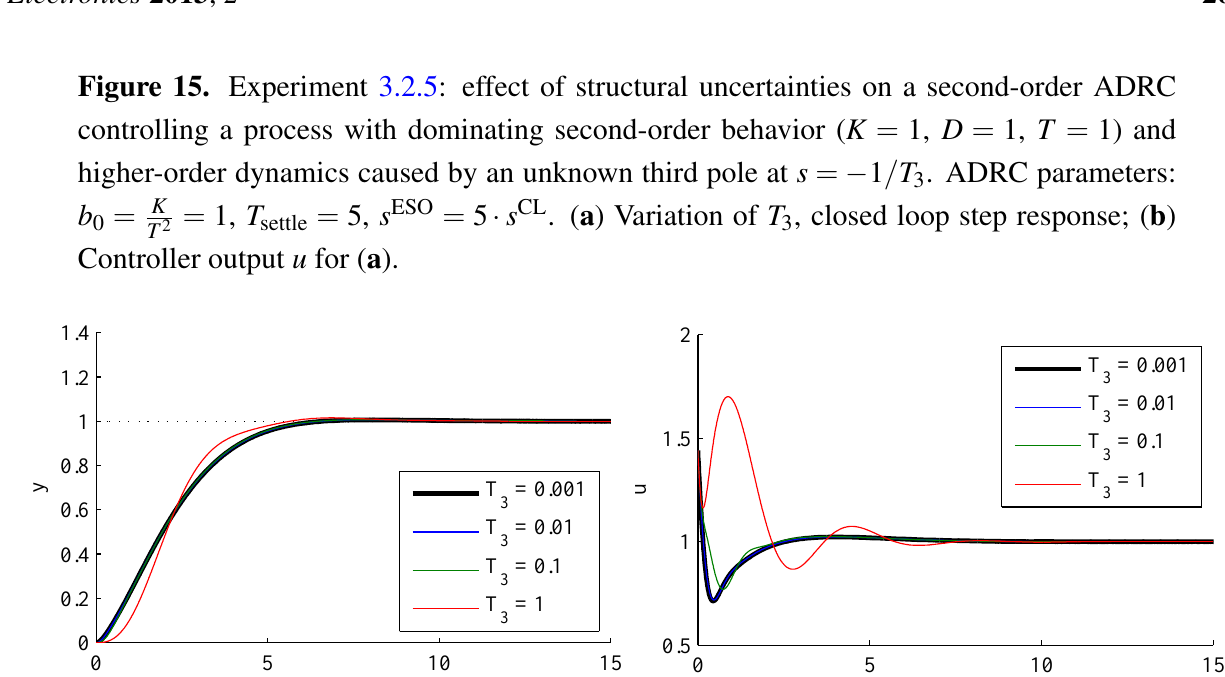
1 / T . ADRC parameters: 3 − , closed loop step response; ( b ) 3